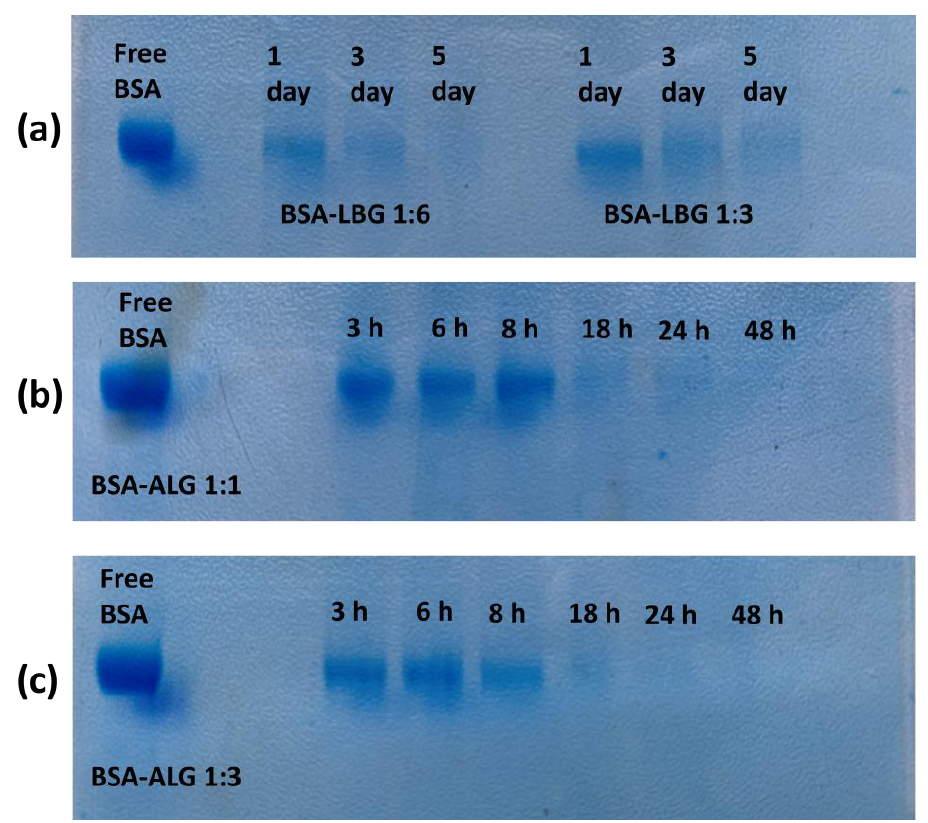
Figure 7. Sodium dodecyl sulfate–poly acrylamide gel electrophoresis pattern of BSA conjugates: ( a ) BSA–LBG 1:3 and 1:6; ( b ) BSA–ALG 1:1; ( c ) BSA–ALG 1:3.